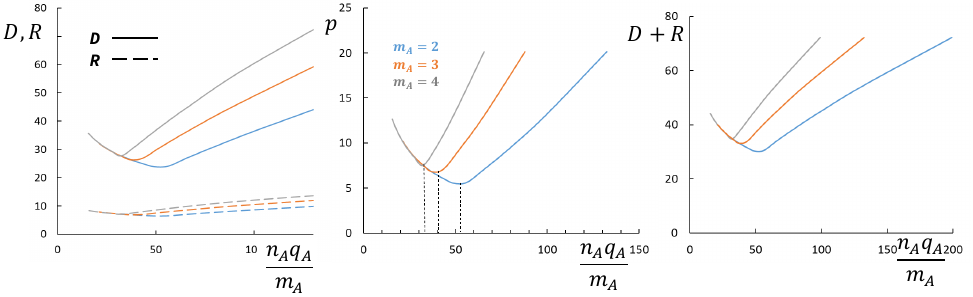
Figure 6. Aggregation number p , core radius R (dashed lines), and corona thickness D (solid lines), and overall radius, R + D , of micelles formed by block copolymers with N B = 150 and N A = 100 as a function of n A q A / m A . m A is varied, as indicated in the figure. Other parameters are q A = 1, γ = 1, v = 1, φ B = 1. The crossover between bottlebrush and miktostar shapes of the A -block is indicated by vertical dashed lines in the middle panel.